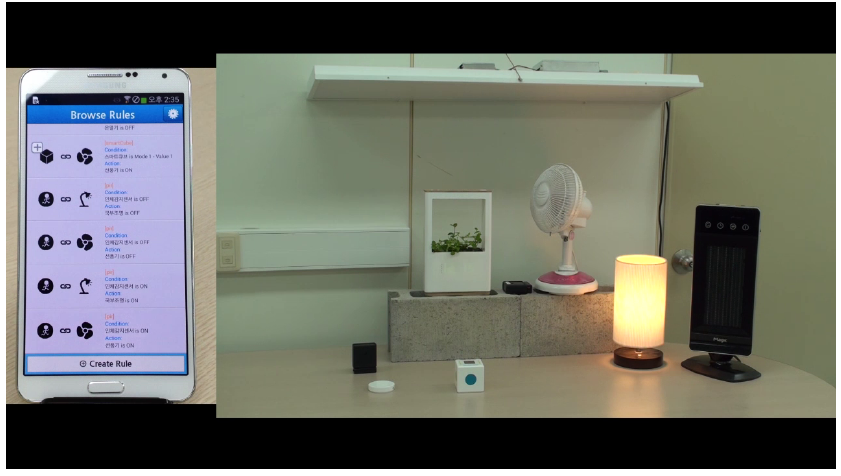
Figure 7. A captured image of the TTEO service